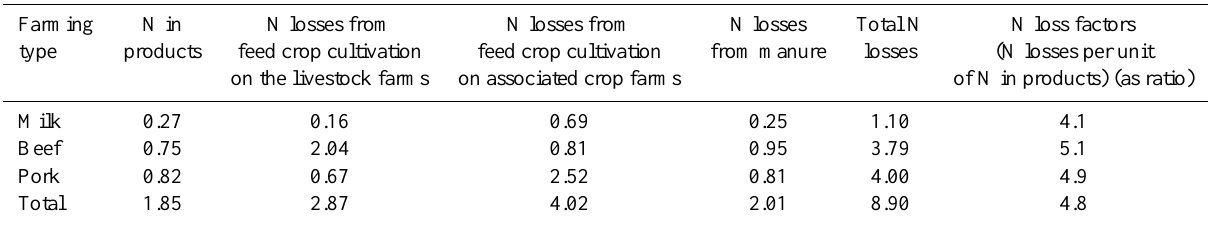
Table 3. N consumption per product, N loss and N loss factors for pork, beef and milk production. All units are in kgNcap − 1 yr − 1 unless otherwise